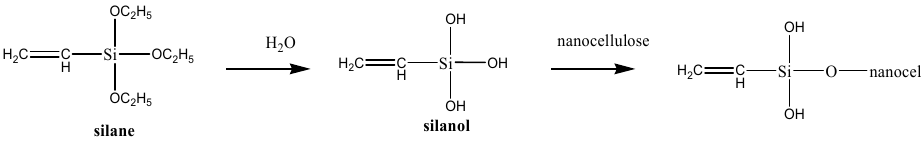
Figure 8. Silylation process of nanocellulose.